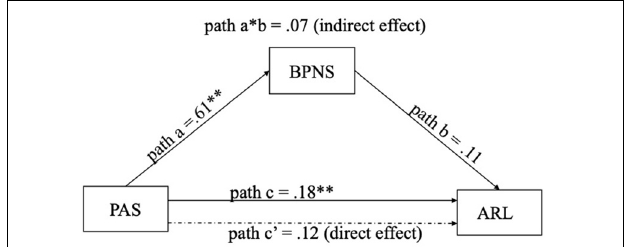
FIGURE 3 | Relationships between BPNS, PAS, and ARL. BPNS, basic psychological need satisfaction; PAS, parental autonomy support; ARL, autonomous regulation of